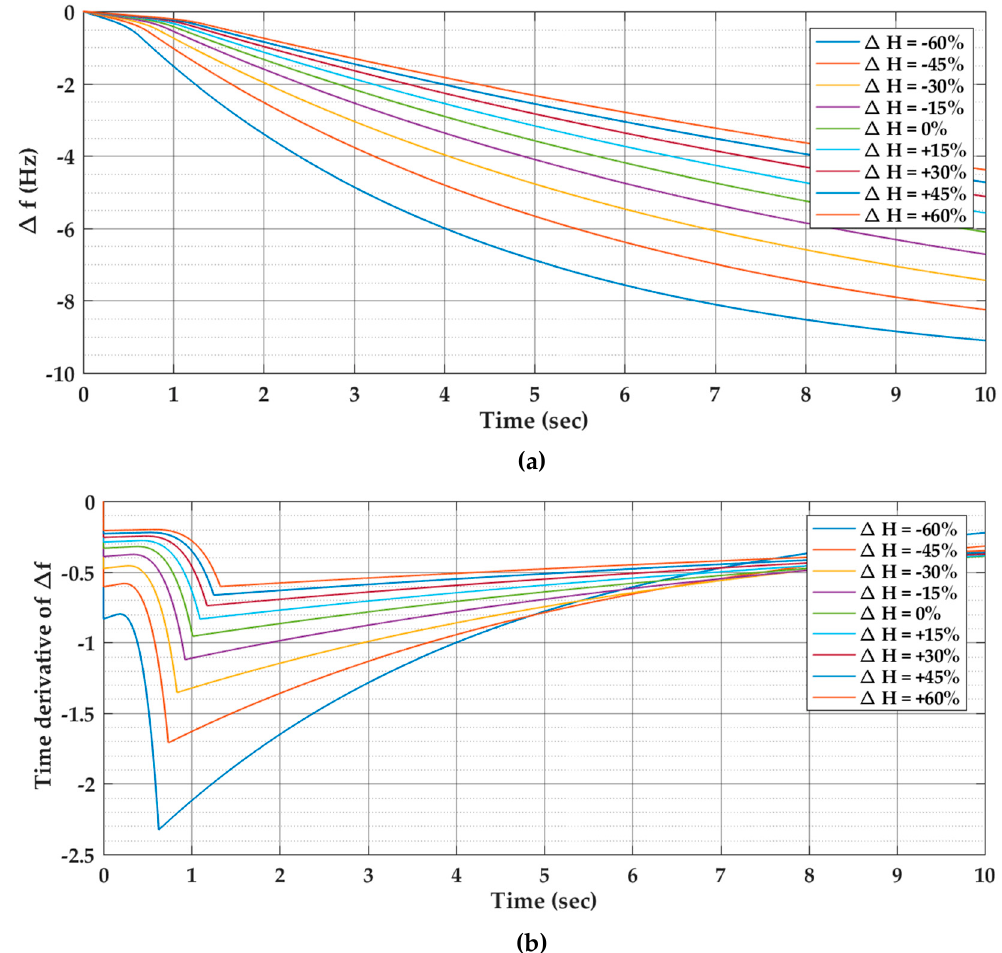
Figure 5. Effects of varying H on the PSFR for an unstable power system with primary control. ( a ) Frequency deviation due to step load disturbance. ( b ) Rate of change of the frequency deviation.